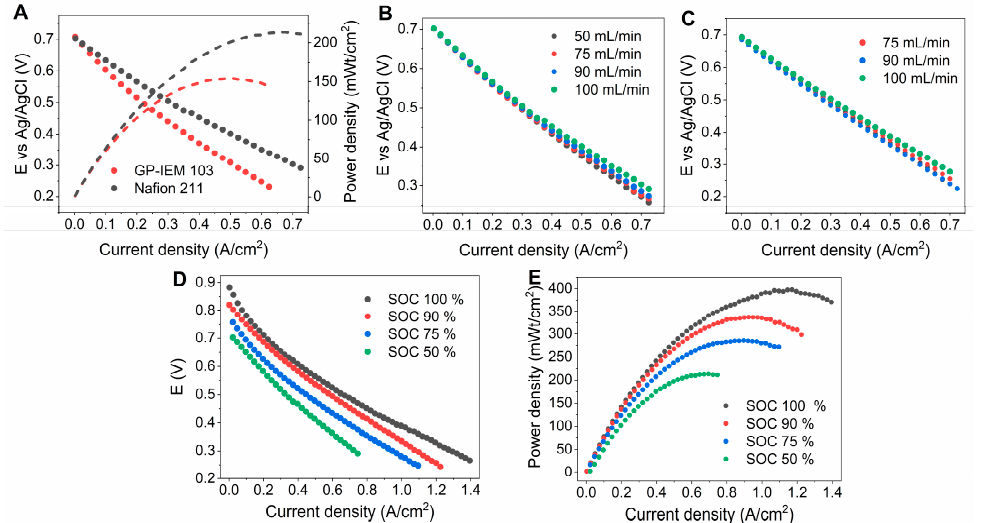
Figure 4. ( A ) Polarization curves (dots) and corresponding power densities (dash) of ABRFB with GP-IEM-103 and Nafion 211 membrane at SOC 50%, Flow field—serpentine, flow rate—50 mL min − 1 ( B , C ) Polarization curves of ABRFB with Nafion 211 membrane, flow field—serpentine ( B ), flow- through ( C ) polarization curves at SOC 50% at different flow rates ( D ) Polarization curves of ABRFB with Nafion 211 membrane, flow field—flow through, flow rate 100 mL min − 1 , SOC changes from 50% to 100% ( E ) Corresponding power densities. ASM as a negolyte in all cases. Table 1. Peak power density of ABRFB at SOC 50% for different flow fields and flow rate. Negolyte— ASM, Membrane—Nafion